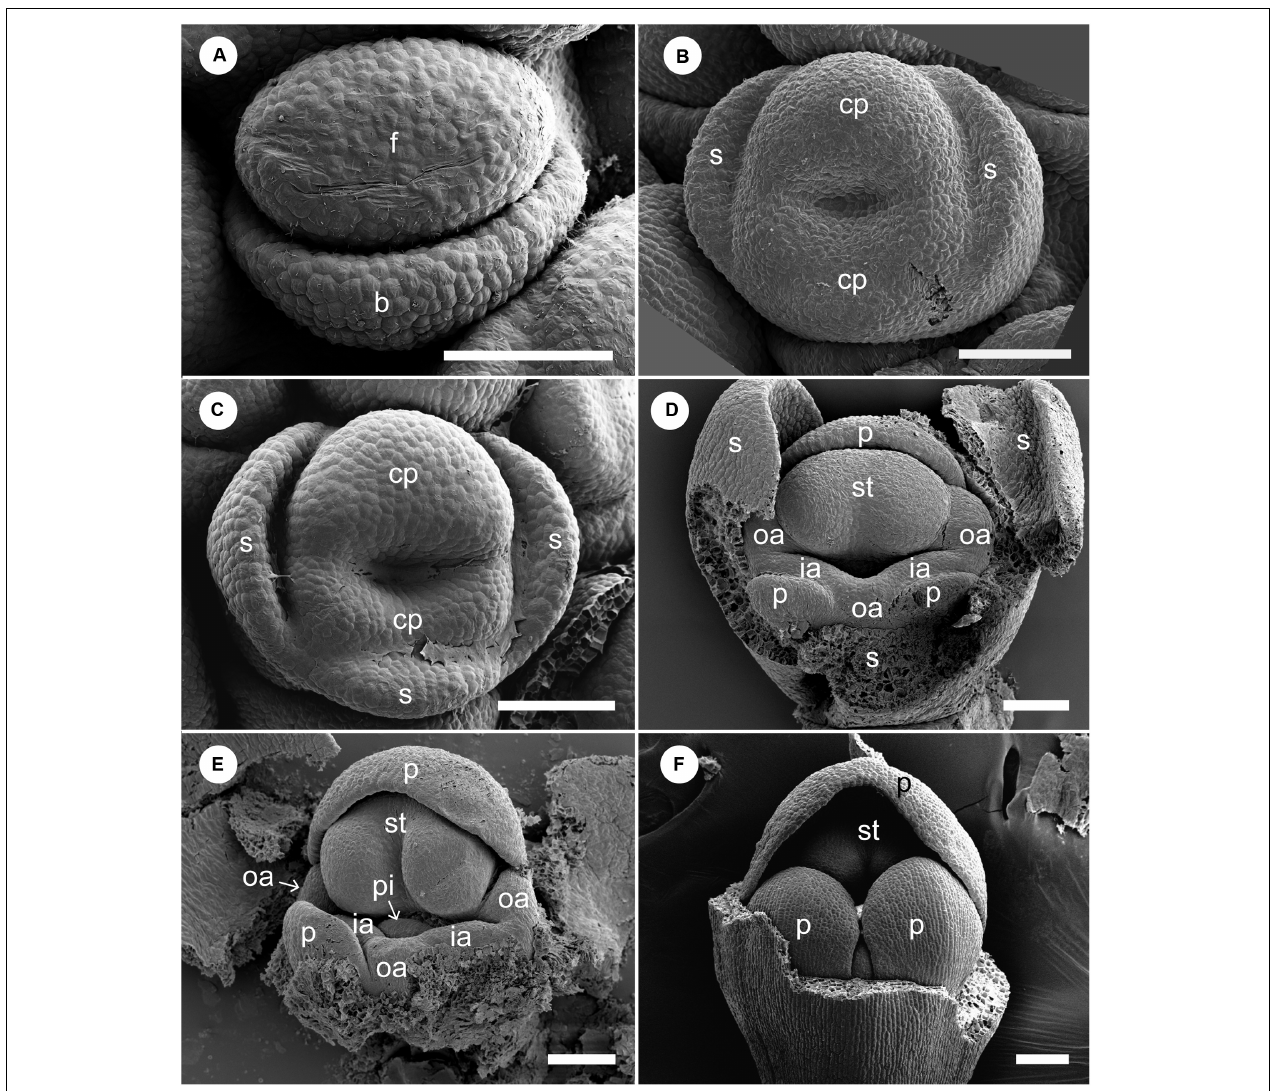
FIGURE 7 | Floral development of Gagnepainia harmandii. (A) Flower at the earliest stage. Dome-shaped floral bud (f) and bract primordium (b) are initiated. (B) Two lateral sepal primordia (s) and ring primordium are initiated. The ring primordium can be separated into three primordia [adaxial and abaxial common primordia (cp), abaxial sepal primordia]. (C) An abaxial sepal primordium is separated from the abaxial common primordium. The abaxial common primordium divides into two portions. (D) Adaxial petal (p), stamen (st), and two outer androecial primordia (oa) are derived from the adaxial common primordium, while two abaxial petal and inner androecial primordia (ia) are derived from the abaxial common primordium. An abaxial outer androecial primordium is also initiated from the abaxial common primordium, although the boundaries with inner androecial primordia are unclear. (E) The style of the pistillate primordium appears. The abaxial outer androecial primordium develops further and the boundaries with inner androecial primordia become clear. Sepal primordia are removed. (F) The abaxial petal primordia develop and cover the abaxial side of the stamen. Sepal primordia are removed. b, bract primordium; cp, common primordium; f, floral bud; ia, inner androecial primordium (staminode primordium); oa, outer androecial primordium (staminode primordium); p, petal primordium; s, sepal primordium; st, stamen primordium. Scale bars = 100 µ